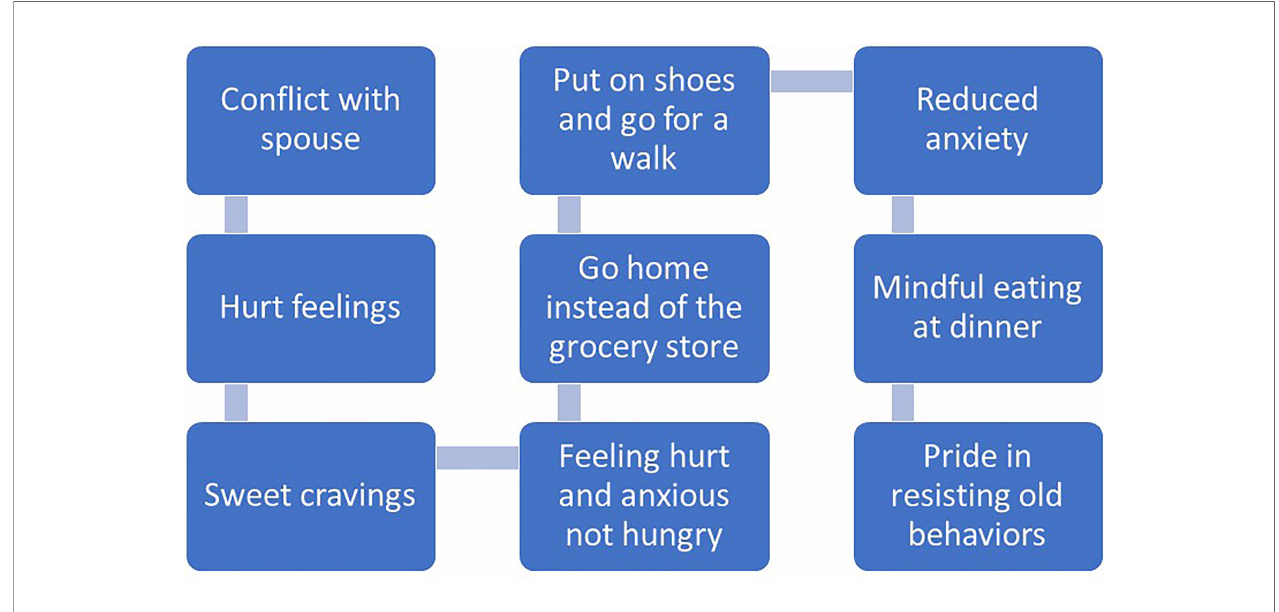
FIGURE 2 | Positive behavioral chain